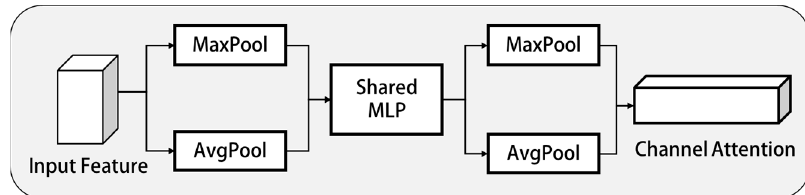
Figure 5. Channel attention module.